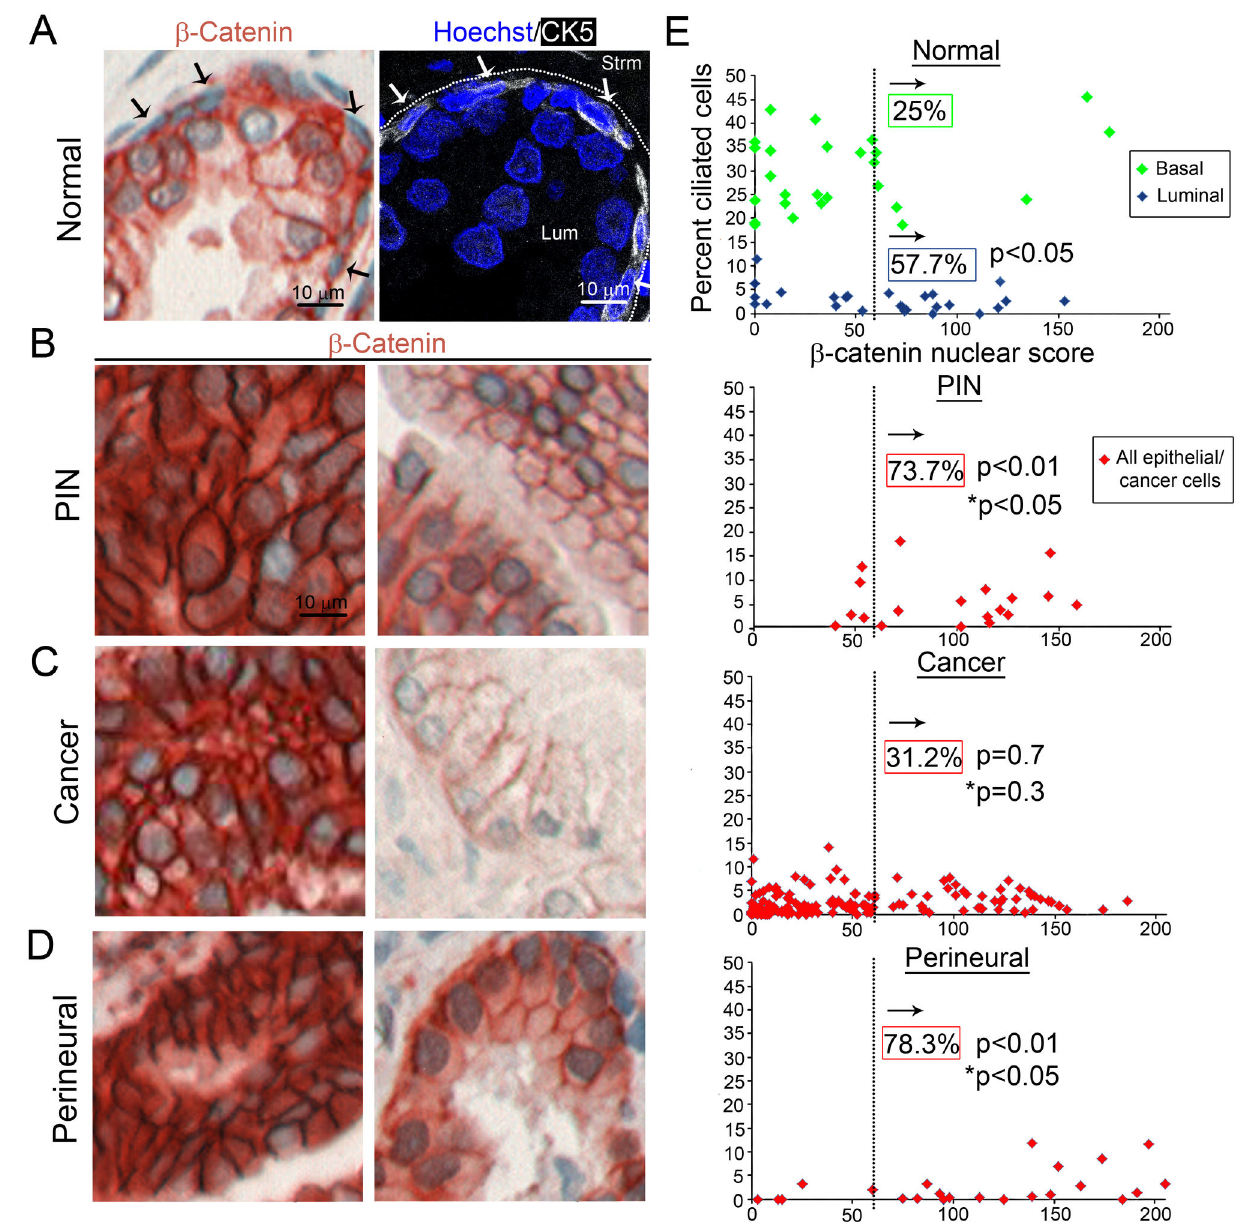
Figure 5. Primary cilia loss correlates with greater nuclear β-catenin in normal. (A) Immunohistochemistry (IHC) images of β- catenin staining in normal prostate, demonstrate a lack of β-catenin localization in basal cells (blue nuclei, black arrows; left). Basal cells were identified based on position, morphology, and cytokeratin 5 (CK5) staining in the adjoining serial section (white arrows; right). The lumen (Lum) and stroma (Strm) are labeled. IHC images show different levels and spatial distributions of β-catenin staining in (B) PIN, (C) cancer, and (D) perineural invasion. (E) Graphs display percent ciliated cells versus β-catenin nuclear score. Scattergraphs were plotted per location for normal, PIN, cancer, and perineural invasion tissue. For normal, basal cells (green) and luminal cells (blue) are shown. For PIN, cancer and perineural invasion, all epithelial/cancer cells are plotted red. High nuclear β- catenin was defined as the 75 th percentile of normal, denoted by the dotted line, and was used to compare normal to PIN, cancer and perineural cells. Percentages represent the locations with high nuclear β-catenin. Statistical analysis was performed using linear regression and included all of the data points, and comparisons to normal basal cells are denoted with p, and comparisons to normal luminal cells are denoted with p*.